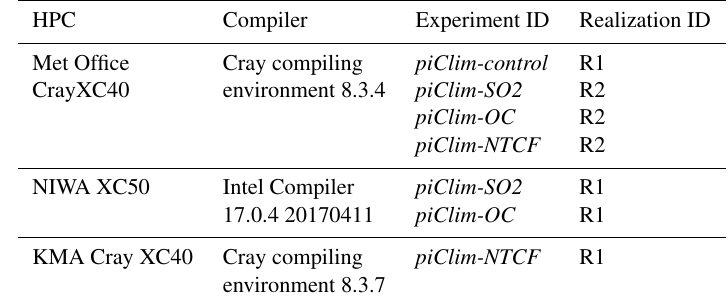
Table 2. List of atmosphere-only PI control ( piClim-control ) and duplicate perturbation experiments ( piClim-X ) carried out with UKESM1 on different HPC platforms.